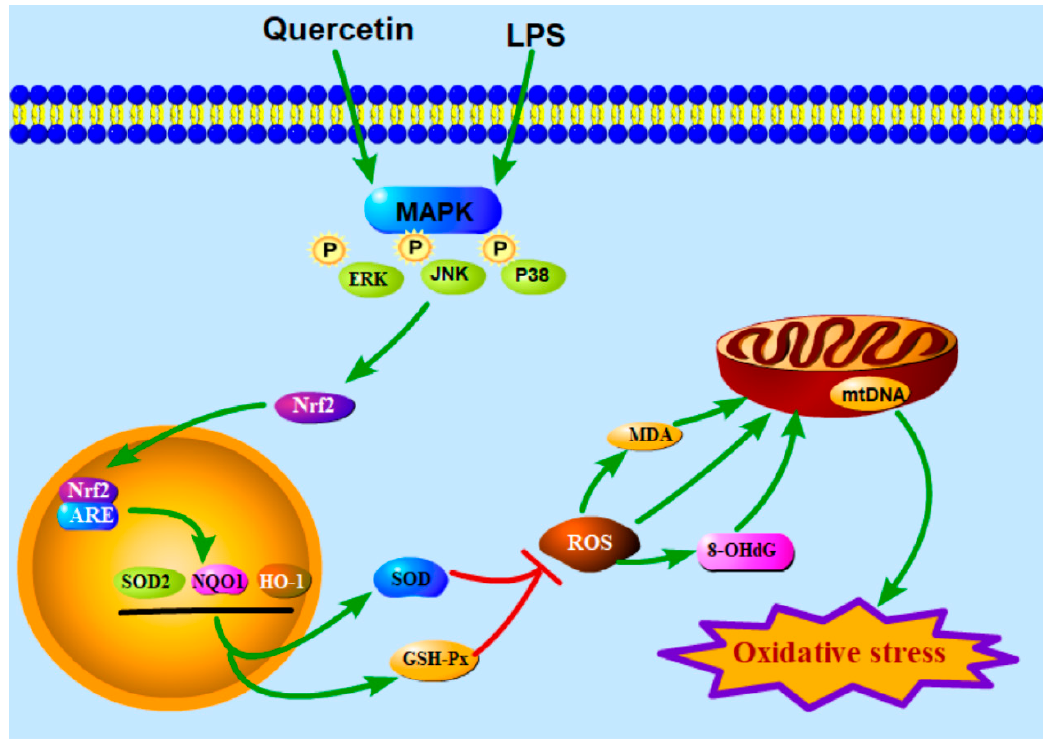
Figure 5. A scheme depicting the effects of quercetin activating the Nrf2 pathways to inhibit Figure5. Aschemedepictingthee ff ectsofquercetinactivatingtheNrf2pathwaystoinhibitLPS-induced LPS-induced intestinal oxidative stress. intestinal oxidative